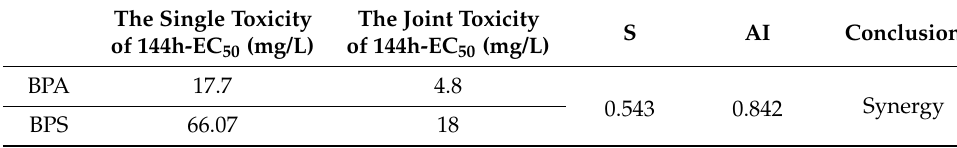
Table 2. Adjustment results of the 144 h joint toxicity